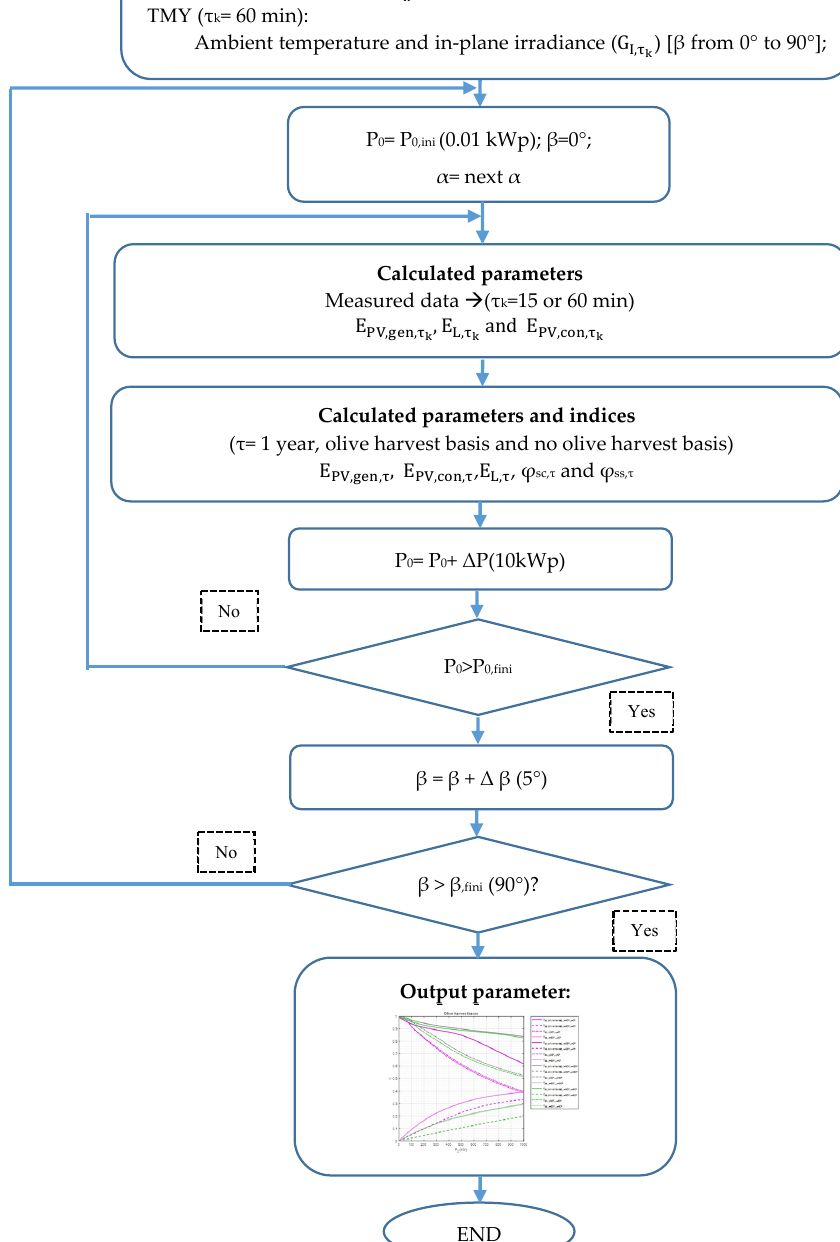
Figure 1. How to plot Φ sc and Φ ss as a function of the nominal array power, P 0 [51,52,64]. Figure 1 How to plot Ф sc and Ф ss as a function of the nominal array power, P 0 [51,52,64]. The percentage error (PE) when analyzing the matching capability due to di ff erent recording where P 0,fini corresponds to 1000 kWp and β fini has a value of 90° . intervals may be expressed as